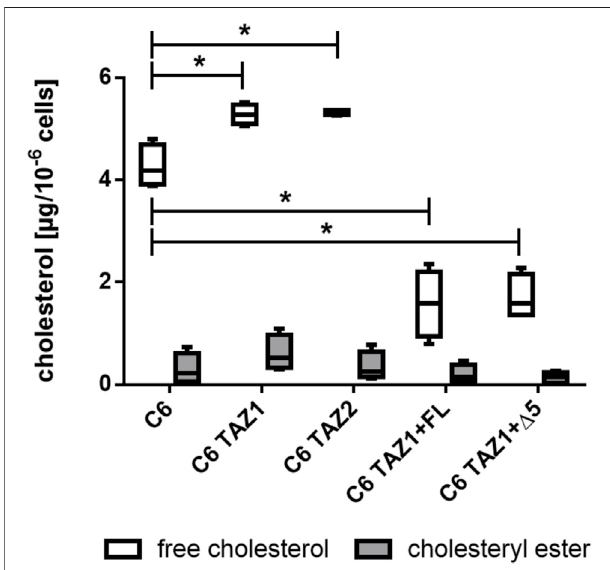
FIGURE 9 | Cellular content of cholesterol (free and esteri fi ed) in C6, C6 TAZcells,andinresponsetore-expressionoffulllengthtafazzin(C6TAZ+FL) or tafazzinlackingexon5(C6TAZ+ Δ 5). n =4biologicalreplicates(data given as a boxplot with median, quartile and interquartile